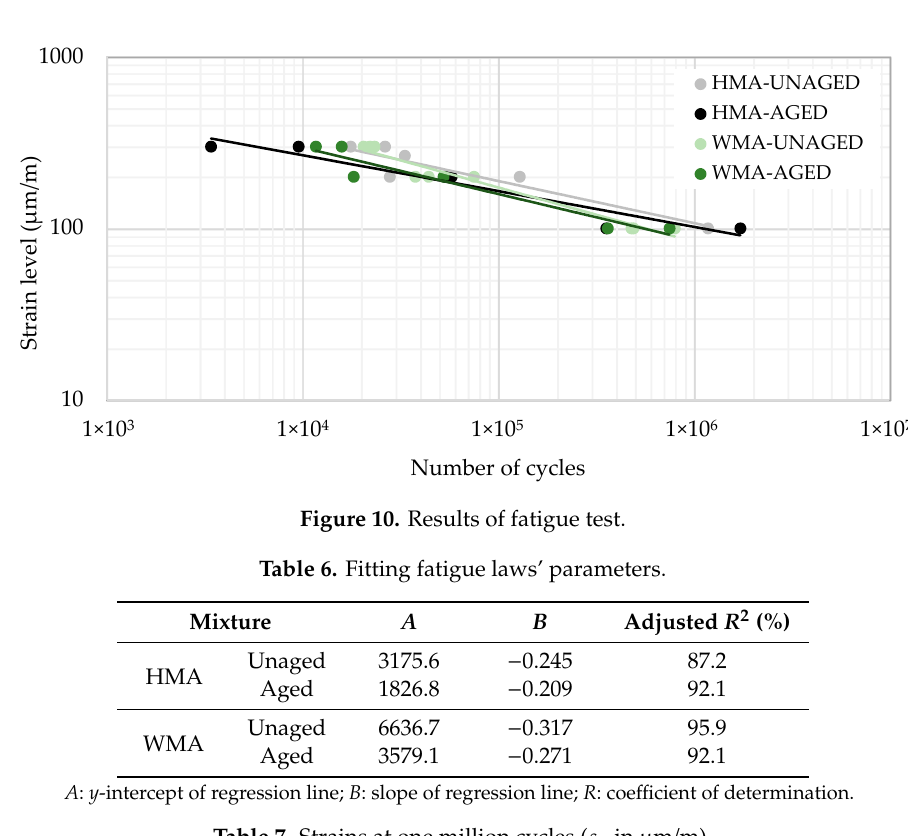
Table 7. Strains at one million cycles ( ε 6 in µ m /